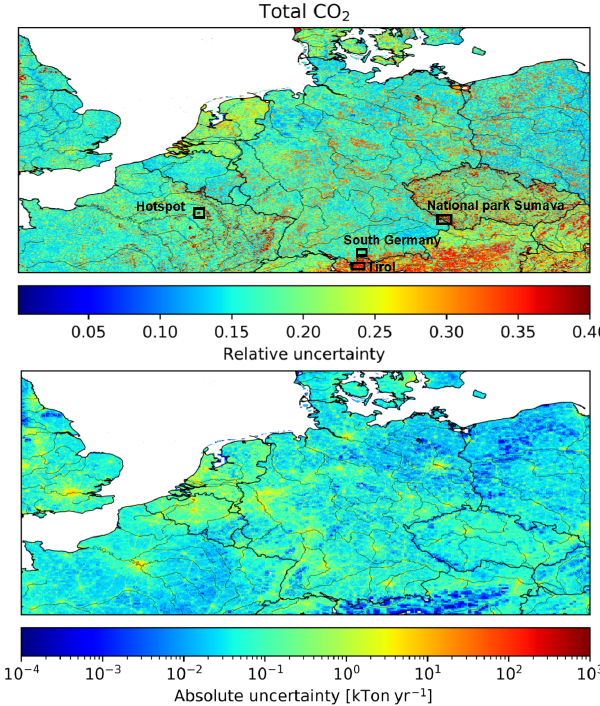
Figure 14. Maps of the relative and absolute uncertainty in CO 2 emissions. Areas that are examined in more detail are outlined by black squares in the top